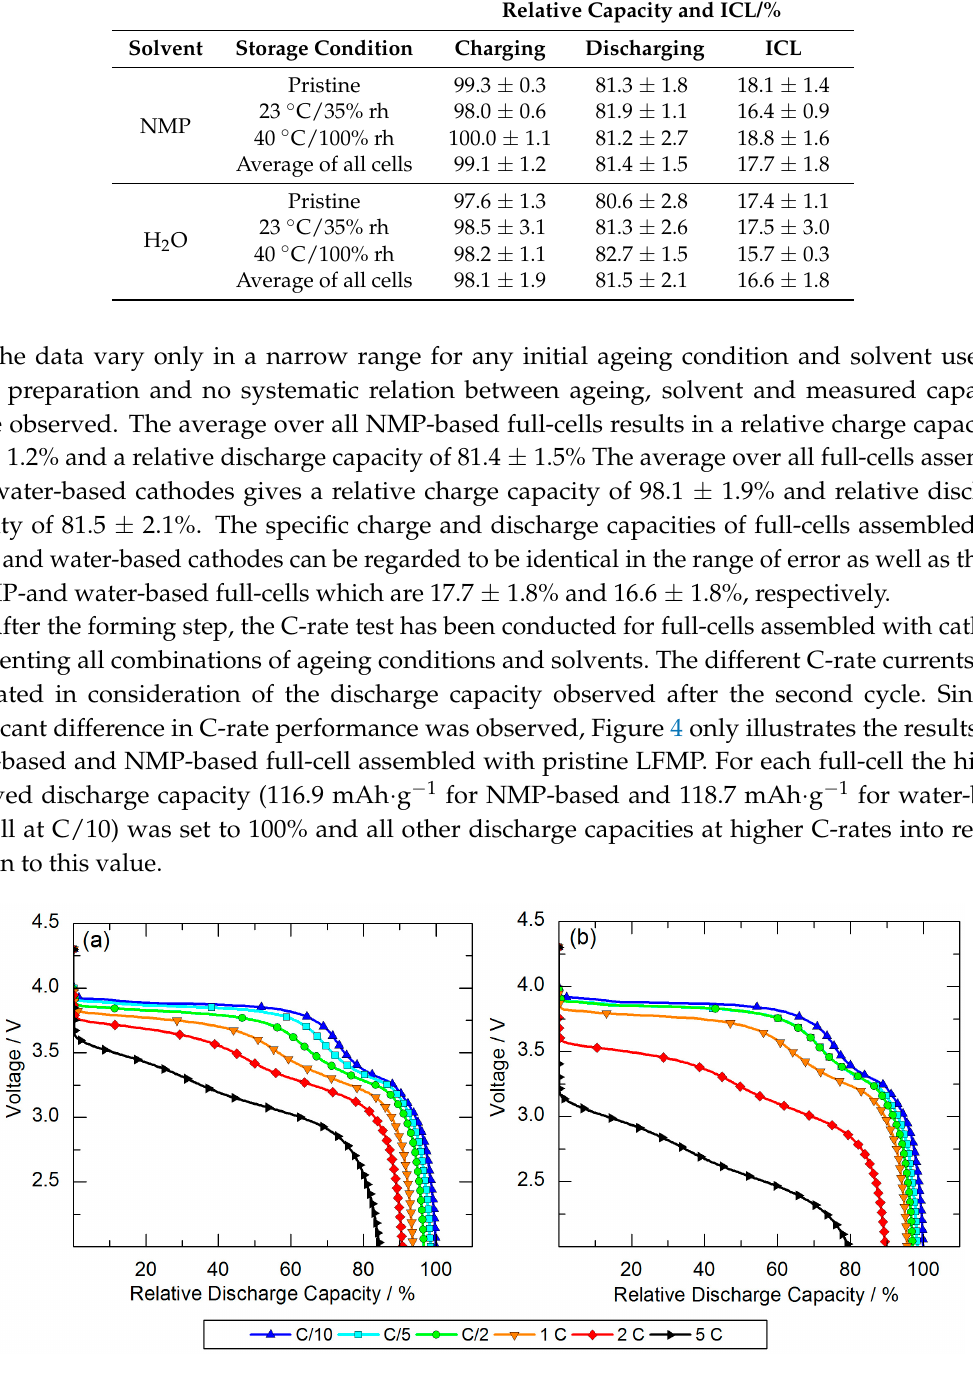
Figure 4. Relative discharge capacities of a water- and NMP-based full-cell prepared with pristine LFMP at different C-rates: ( a ) full-cell assembled with water-based cathode; ( b ) full-cell assembled with NMP-based cathode.